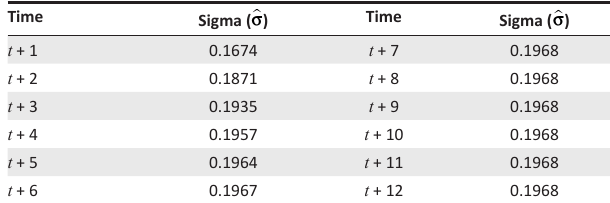
TABLE 4: Future Victoria Falls Rainforest volatility